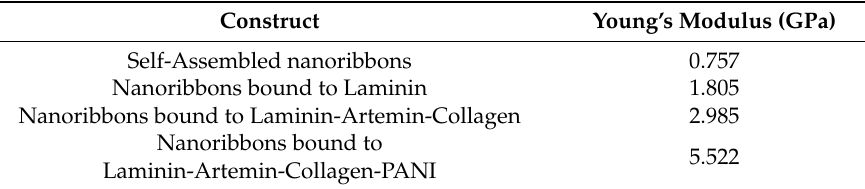
Table 1. Youngs Modulus values of constructs after consecutive incorporation of each